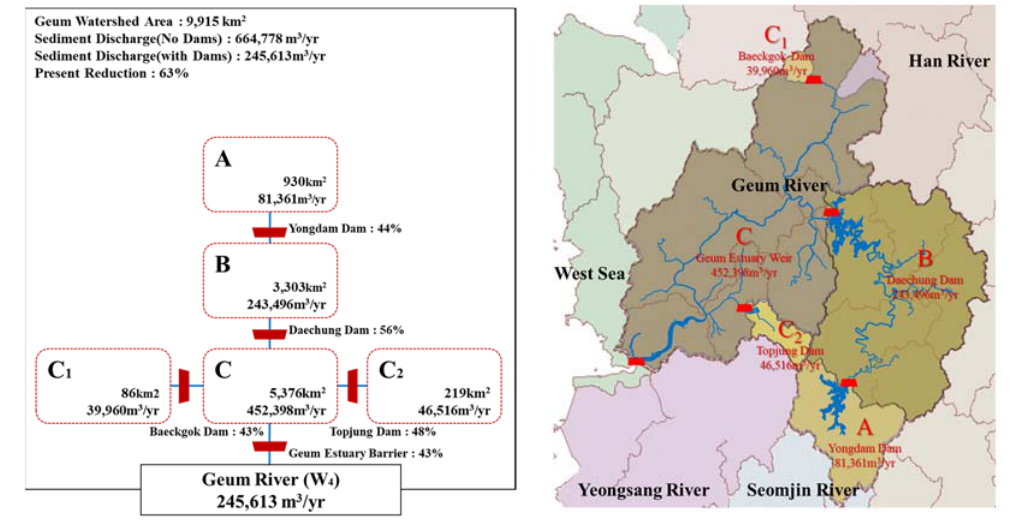
Figure 11. Result of sediment discharge in Geum Estuary. Table 5. Estimated sediment discharge in Geum Estuary.